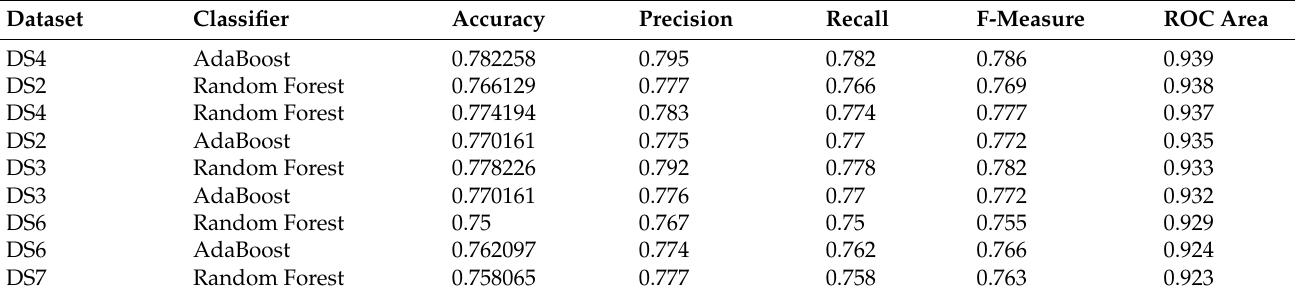
Table 11. Top-ten classifiers according to ROC